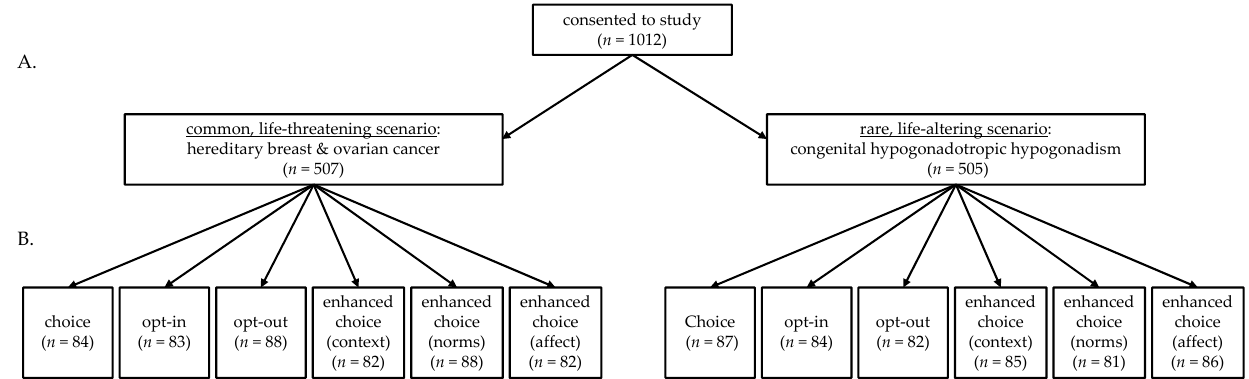
Figure 1. Study schematic. ( A ) Participants were randomized to one of two scenarios then reviewed information about the respective condition. ( B ) Participants were then randomized to one of six frames and made a genetic testing